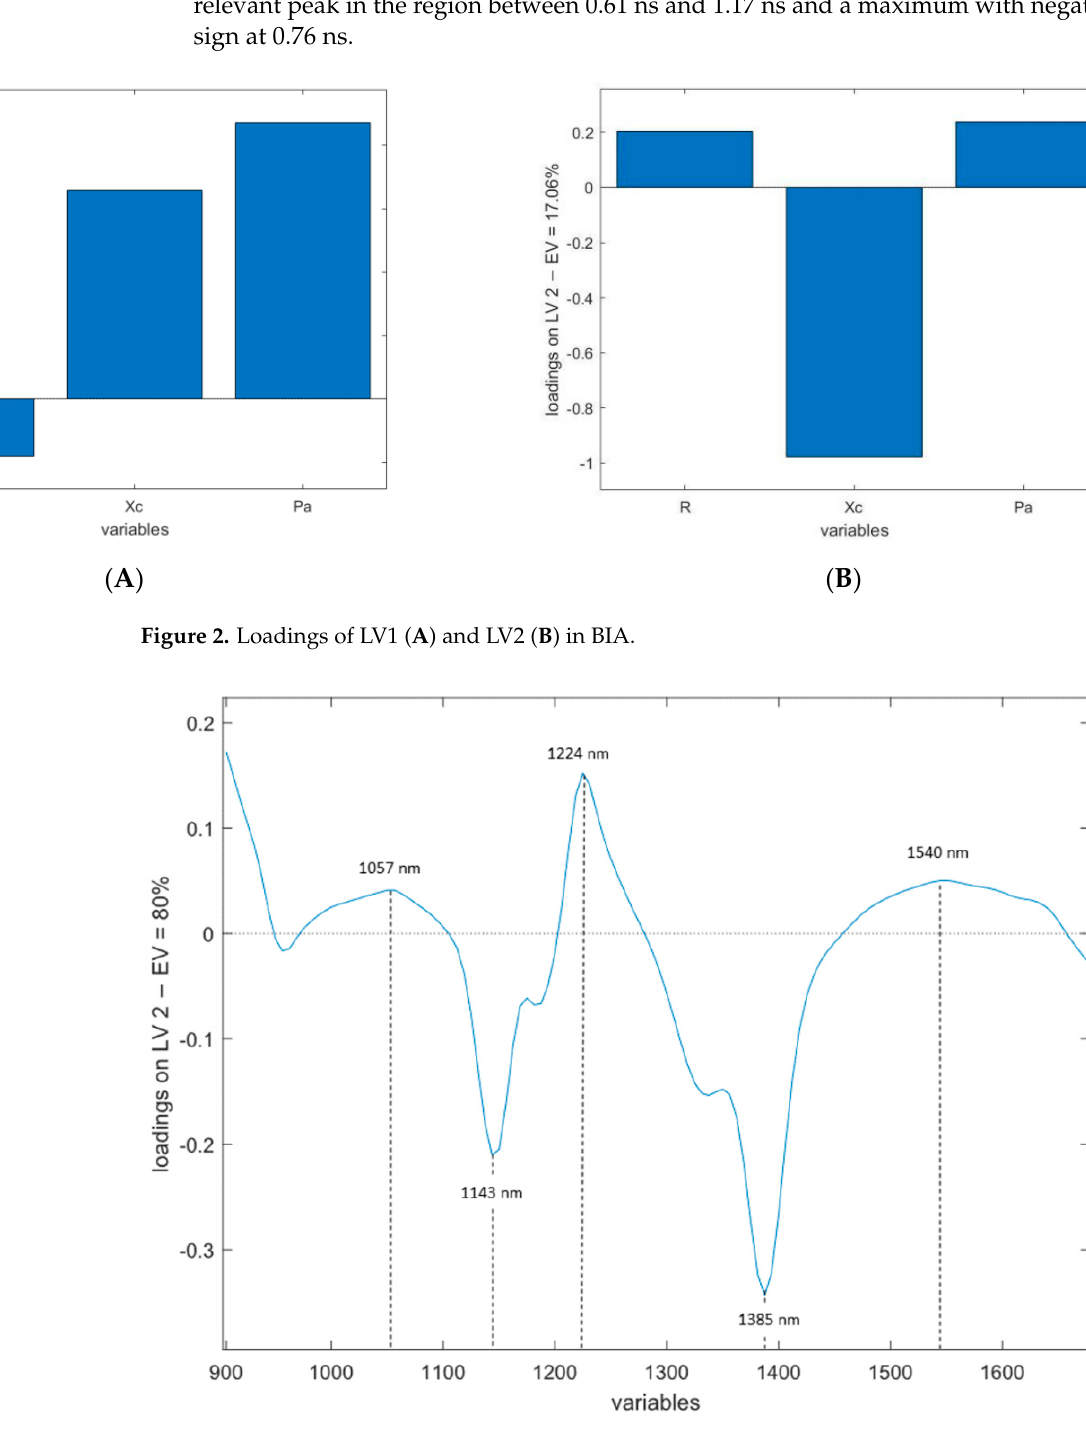
Figure 3. Loading of LV2 in NIR.